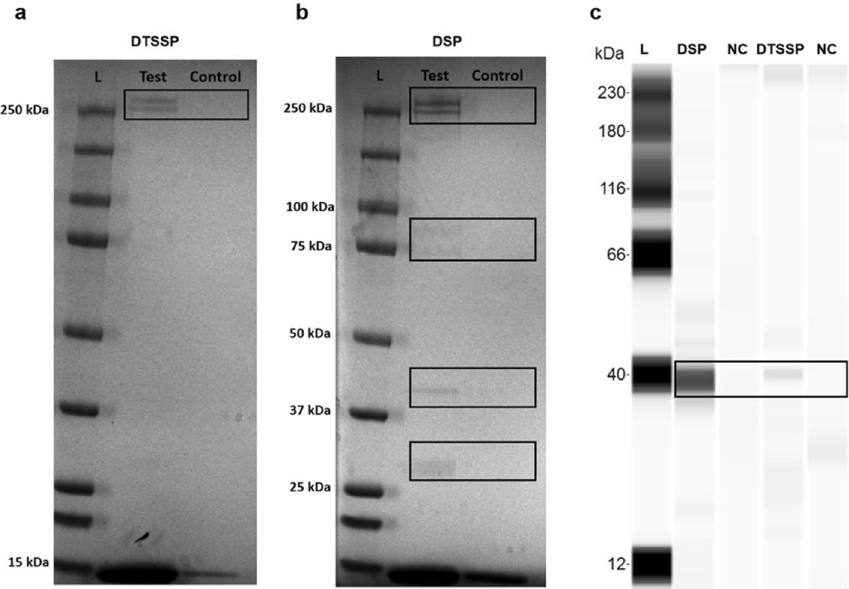
Figure 6. T. equi CLAMP interacts with equine erythrocyte proteins. ( a , b ) show SDS-PAGE gels of proteins (within black boundaries) isolated from the erythrocyte surface (test) and within the cell membrane and cell (test) after crosslinking to CLAMP with DTSSP and DSP, respectively. ( c ) Represents an immunoblot showing the presence of CLAMP at ~ 39 kDa. In all cases agarose resin eluates were used as negative controls (control/NC). The ~ 15 kDa band on the SDS-PAGE gels indicate non-specific binding of the equine α- and β-hemoglobin subunits to the Thermo Scientific AminoLink (test) and agarose (control) coupling resins.